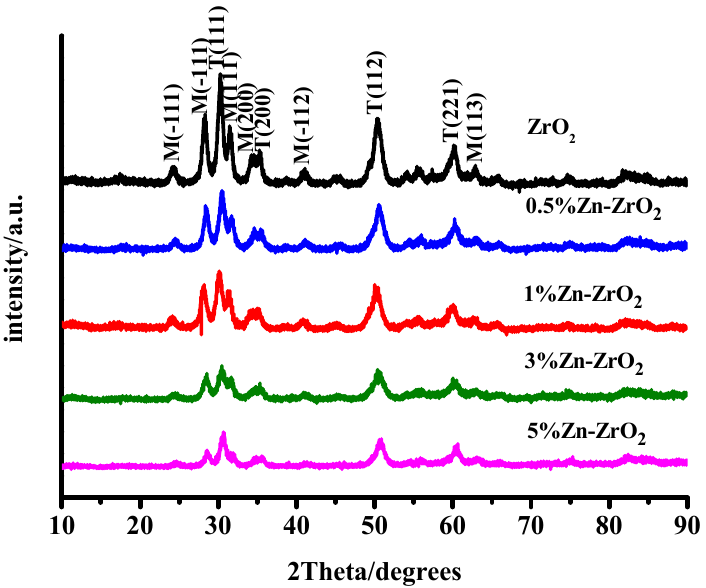
Figure 2. XRD diagrams of the ZrO 2 and Zn–ZrO 2 (0.5–5%) NP samples.